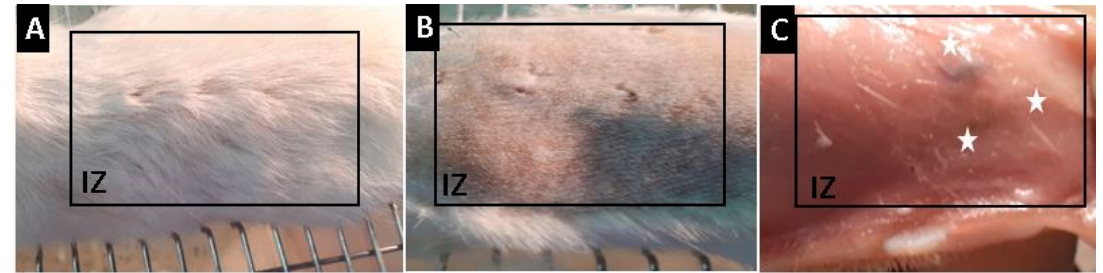
Figure 10. Macroscopic appearance of the Wistar’s rat skin implanted. ( A ) : Formation of new skin. ( B ) : Skin after shaving. ( C ): Subdermal appearance of the skin. IZ: Implanted zone. Stars : Implanted material.